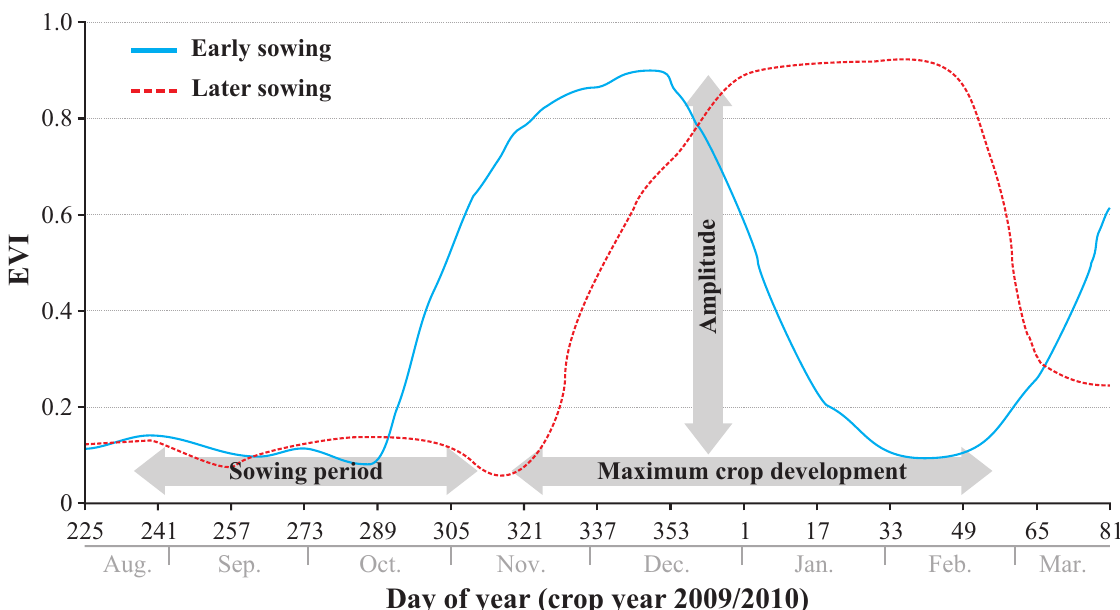
Figure 3. Temporal trajectory of EVI/MODIS values for a typical annual crop indicating the periods of minimum and maximum EVI values and the amplitude. Source: adapted from Rizzi et al .